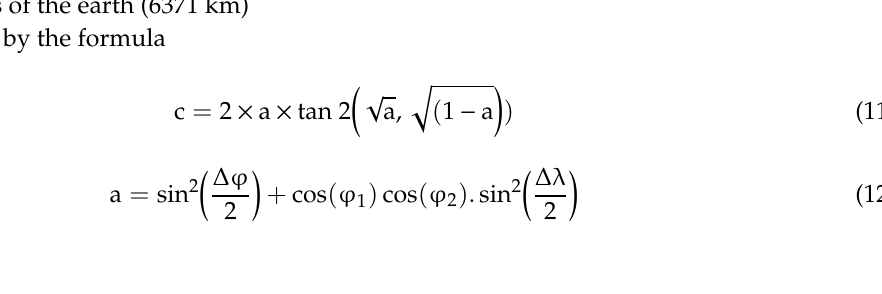
Figure 5. 3D representation of the haversine formula for determining the distance between two drones. R is the radius of the earth (6371